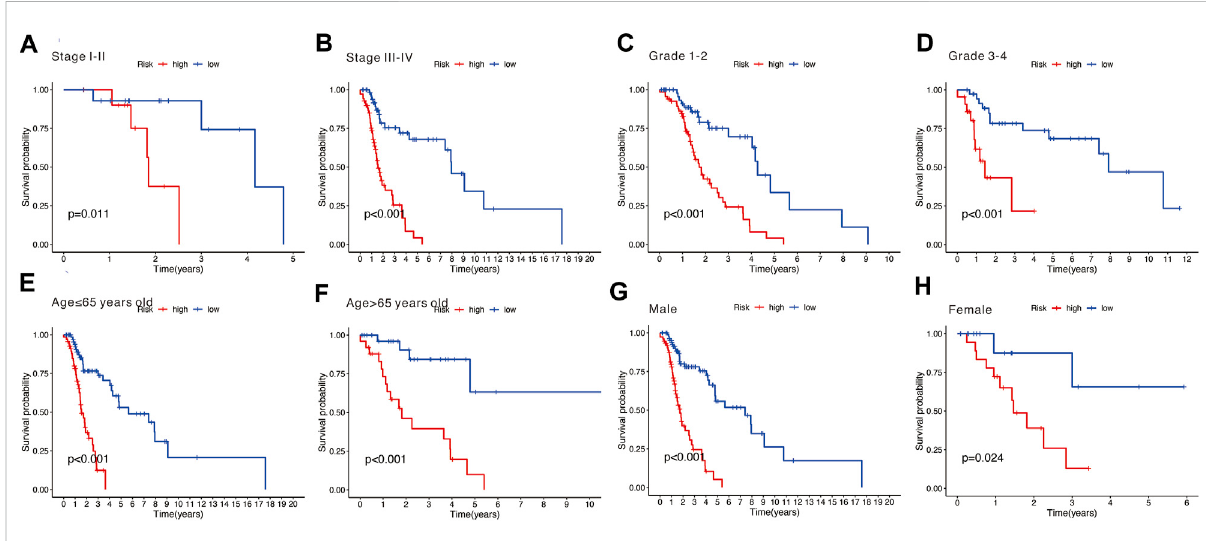
FIGURE 8 (A,B) Subgroup analysis strati fi ed by different tumor stages (stages I – II and stages III – IV). (C,D) Subgroup analysis strati fi ed by different tumor grades(grades1 – 2andgrades3 – 4). (E,F) Subgroupanalysisstrati fi edbydifferentage(over65andunder65years). (G,H) Subgroupanalysisstrati fi ed by different genders (male and